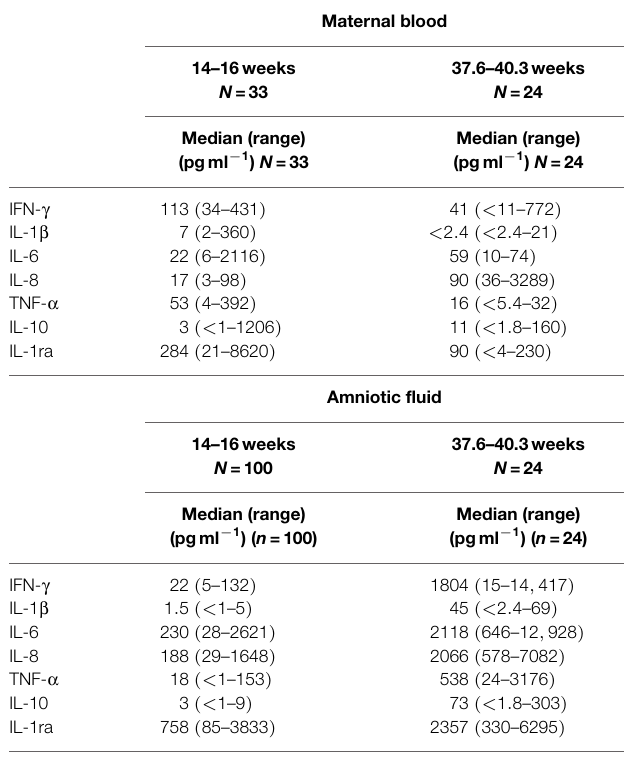
TABLE 1 | Comparison of cytokine levels in maternal blood (a) and amniotic fluid (b) at trimester 2 (10) and trimester 3 . Maternal blood